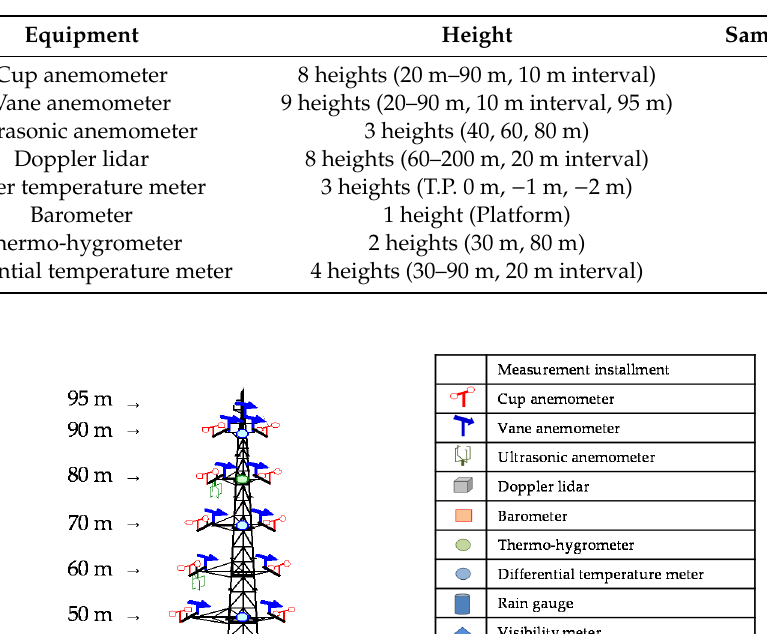
Table 2. Specification of the observations.